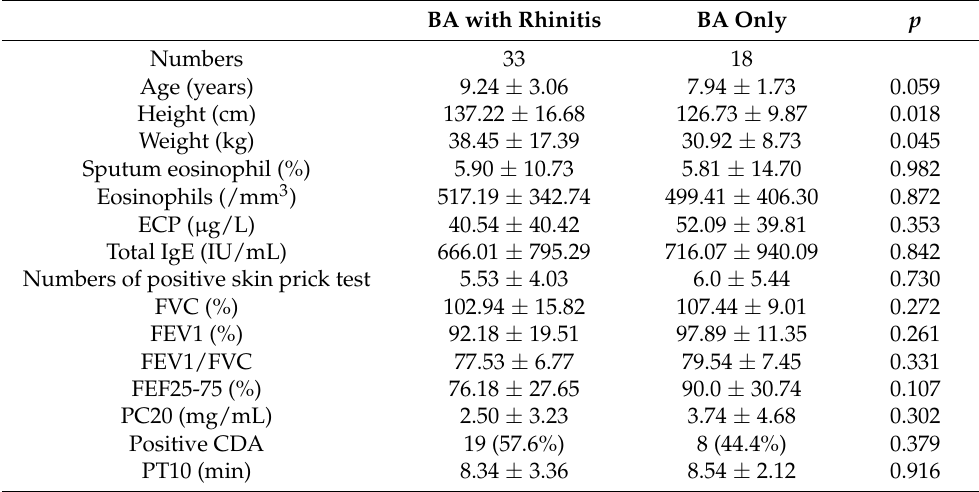
Table 5. Comparisons between BA with rhinitis group and BA only